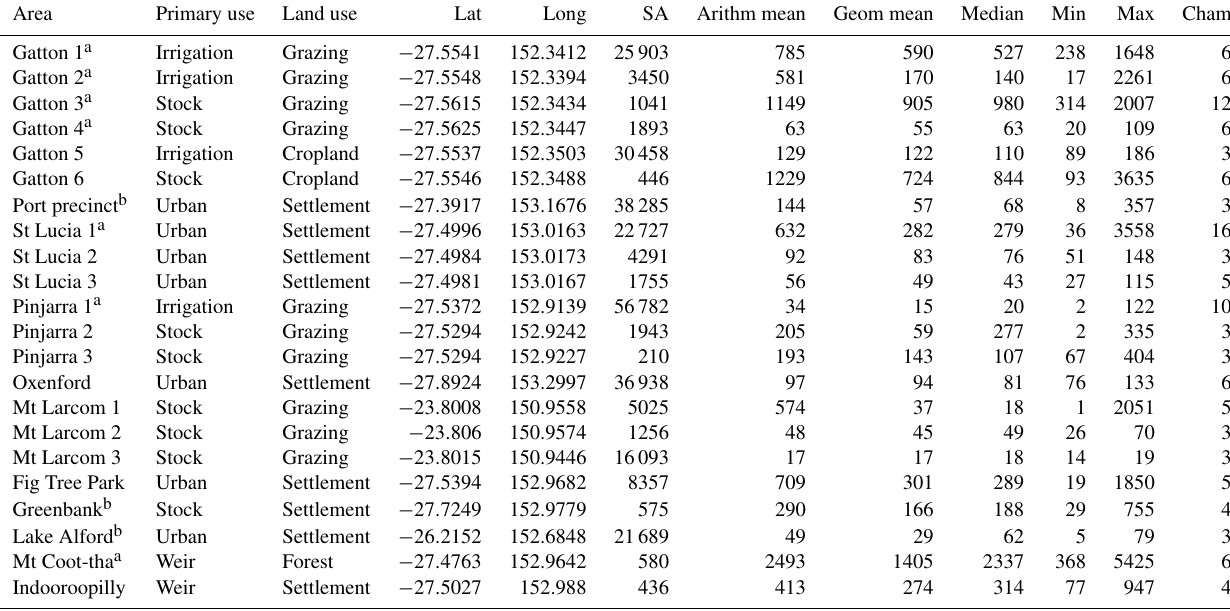
Table A1. Selected characteristics from individual ponds showing primary use of each system; surrounding land use type; location of system latitude (Lat) and longitude (Long); average surface area (SA) inm 2 ; mean, median, minimum (Min) and maximum (Max) methane emission rates (mgm − 2 d − 1 ); and number of chamber measurements on individual systems (Cham). Primary uses included the following: irrigation for cropping; stock watering for cattle and horses; urban uses included storm water management and aesthetic purposes; weirs for water supply and streamflow monitoring. a indicates water bodies where repeat sampling was conducted; b indicates water bodies where deployments of less than 24h were conducted. Geom mean is the geometric mean; Arithm mean is the arithmetic mean.